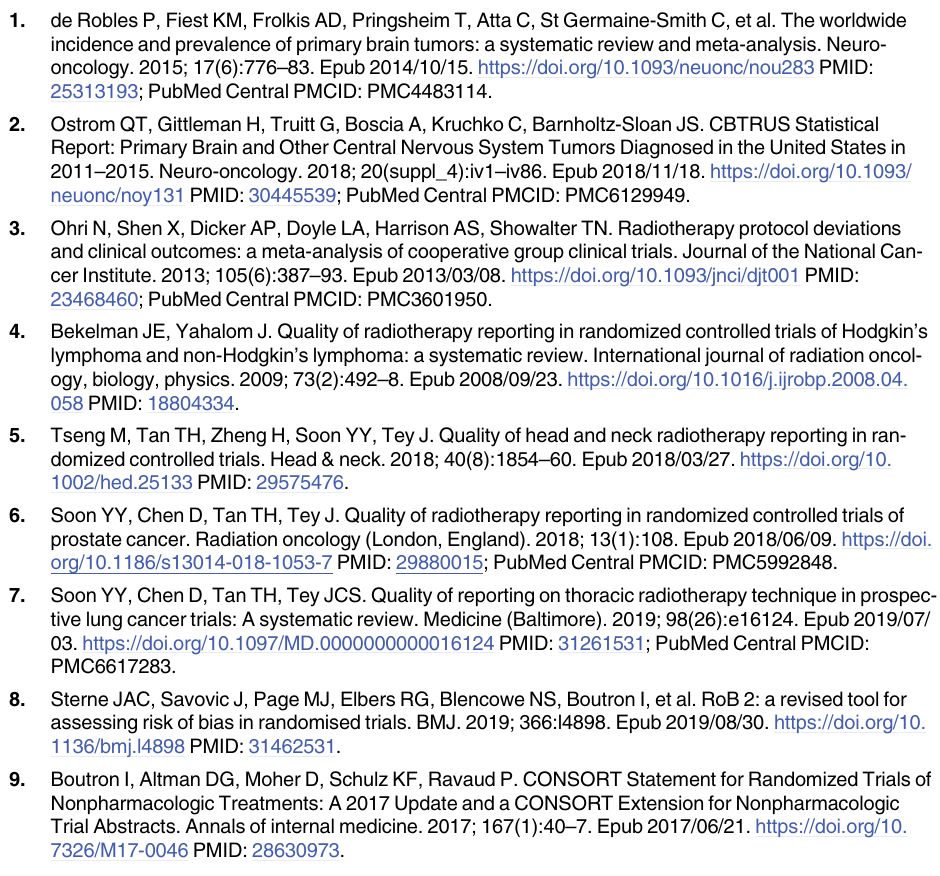
S5 Table. Adequate reporting of each